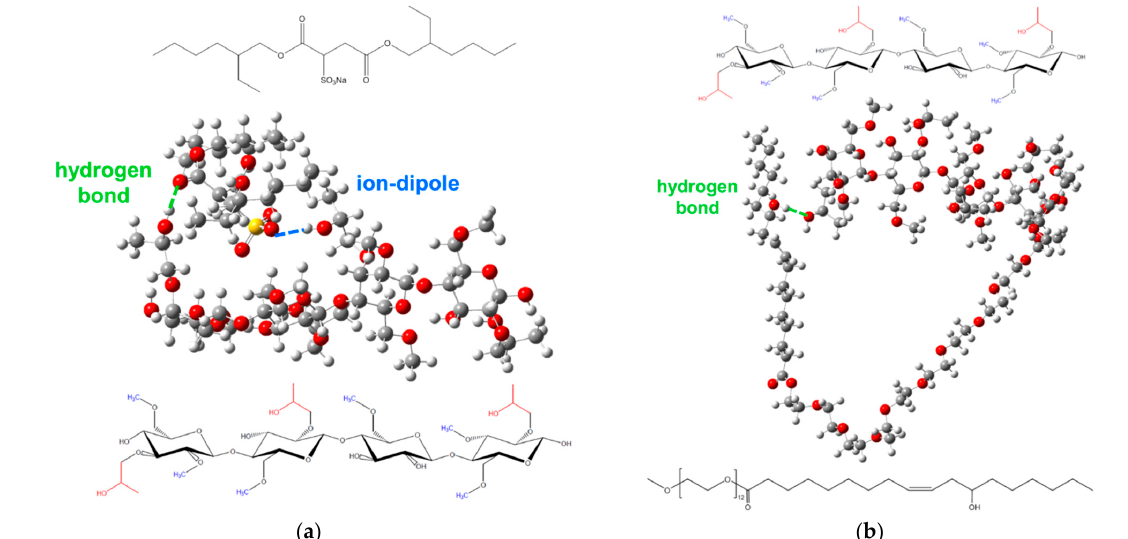
Figure 7. Optimized geometries obtained from DFT simulation in vacuum for ( a ) HPMC–AOT, where the AOT sulfonate group approaches the HPMC hydroxyl group through ion–dipole interaction and through the hydrogen bond between the AOT carbonyl group and the HPMC hydroxyl group and ( b ) the HPMC-Kolliphor ® EL fragment, where the Kolliphor ® EL hydroxyl group interacts with the HPMC hydroxyl group through the hydrogen bond.